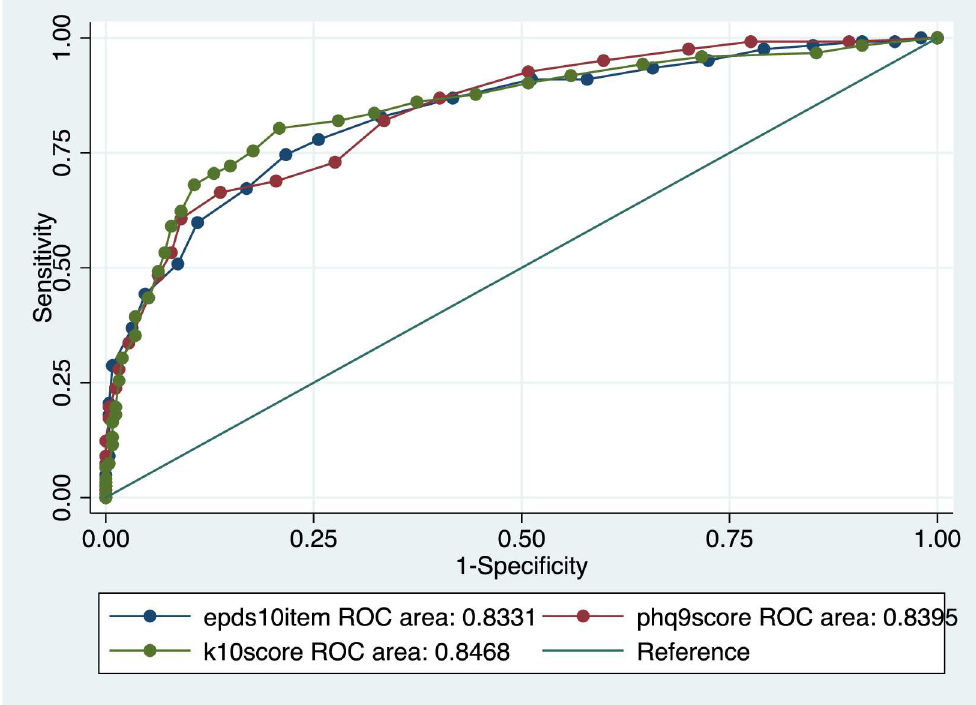
Fig 1. Roc comparison of performance of brief screening tools for detecting MDE and/or anxiety disorders.